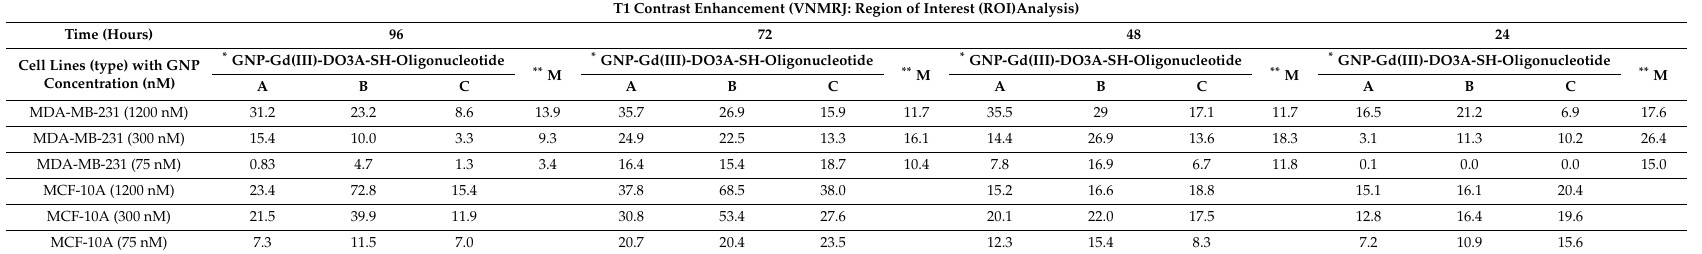
Table 2. T1 Contrast enhancement comparison for GNP-Gd(III)-DO3A-SH Oligonucleotide in MDA-MB-231 and MCF-10A cell lines using Region of Interest analysis at Varian NMR J (VNMRJ) software. T1ContrastEnhancement(VNMRJ:RegionofInterest(ROI)Analysis)